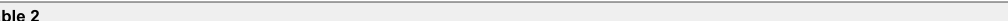
Table 2 All cases with at least one drug prescription between 2006 and 2010 are indicated. The number of prescriptions and the number of drug-drug-interactions (DDI) are outlined as overall sum and as distribution within the DDI severity categories (until 2009 four categories with results, for the last two months of 2009 and for 2010 five categories with results). Category 6 (newly defined in 2009) has no DDI in the entire study period and thus the row is not outlined. The same figures are given for the three different clinics (internal medicine, surgery and orthopedics, gynaecology and obstetrics). # prescriptions (#/case): number of prescriptions and number of prescriptions per in-hospital